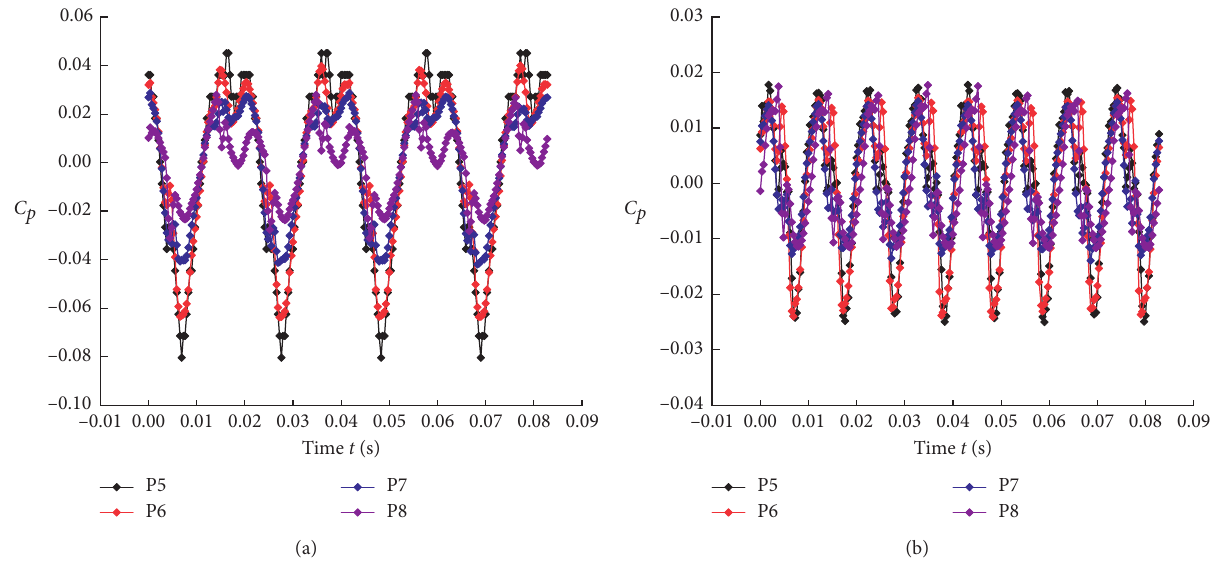
Figure 18: Time domain of each monitoring point at the impeller outlet ( Q � Q